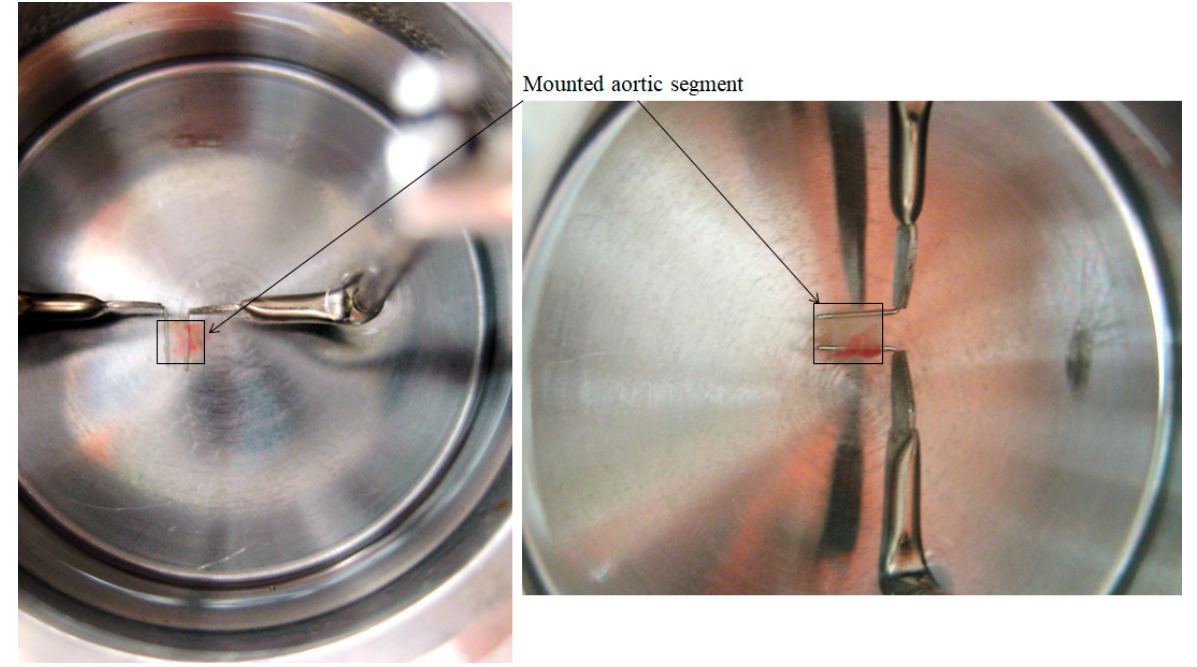
Figure 2. Isolated murine thoracic aorta segment, gradually stretched to the optimal resting tension of 500 mg.